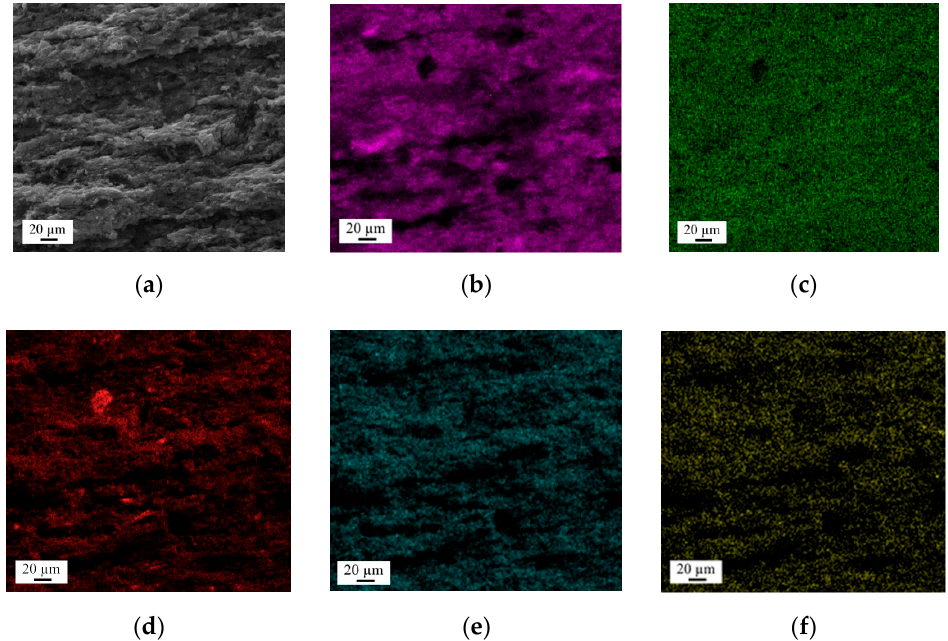
Figure 2. Cross-section of the sample with Ni annealed at 800 ° C: ( a ) SEM image; ( b – f ) element distribution maps. ( b ) Si; ( c ) Ni; ( d ) C; ( e ) O; ( f ) F. distribution maps. ( b ) Si; ( c ) Ni; ( d ) C; ( e ) O; ( f )